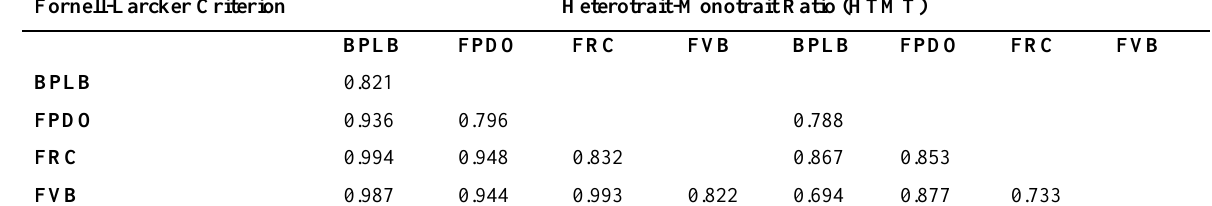
Table 3: Correlations and Discriminant Validity among the variables